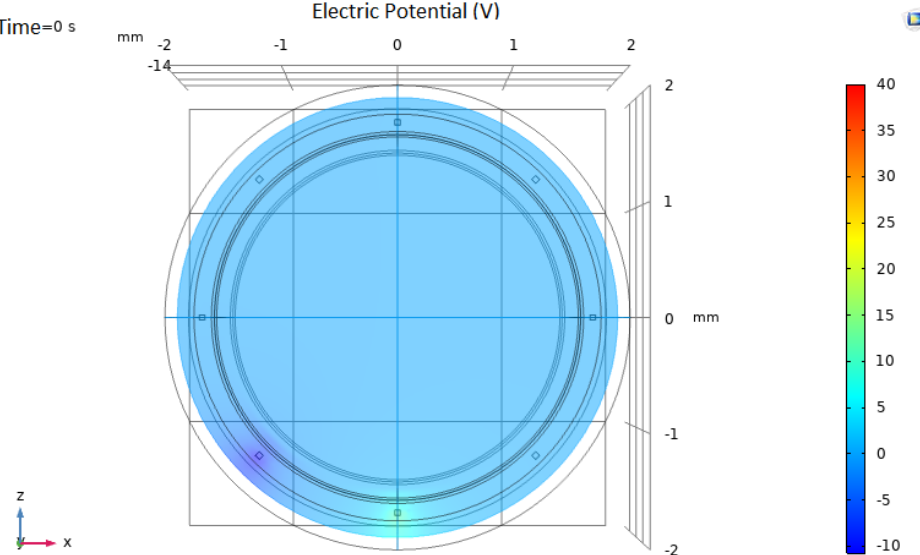
Figure 4. Electrical Impedance Tomography system model. In this particular setting (configuration 5), the lower electrode is set to 10 V and the contiguous electrode is set to − 10 V. Current intensity is measured in the remaining 6 electrodes.